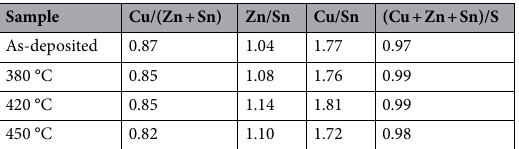
Table 1. As-deposited and sulfurized at different temperature CZTS components chemical